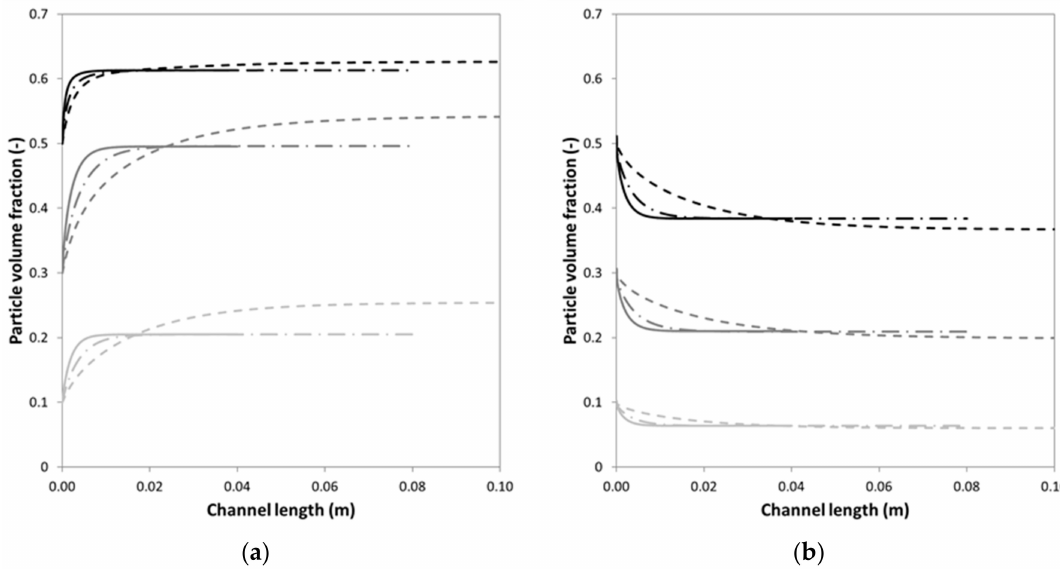
Figure 7. ( a ) Particle volume fraction versus the channel length at the channel centerline and ( b ) at 10% from the wall. Results are shown for three different bulk particle volume fractions: 0.1 (light grey); 0.3 (dark grey); 0.5 (black) and for the cases as given in Table 4: case 1 (solid line); case 2 (dashed line); case 3 (dashed-dotted line); and, case 4 (dotted line). Note, case 1 and 4